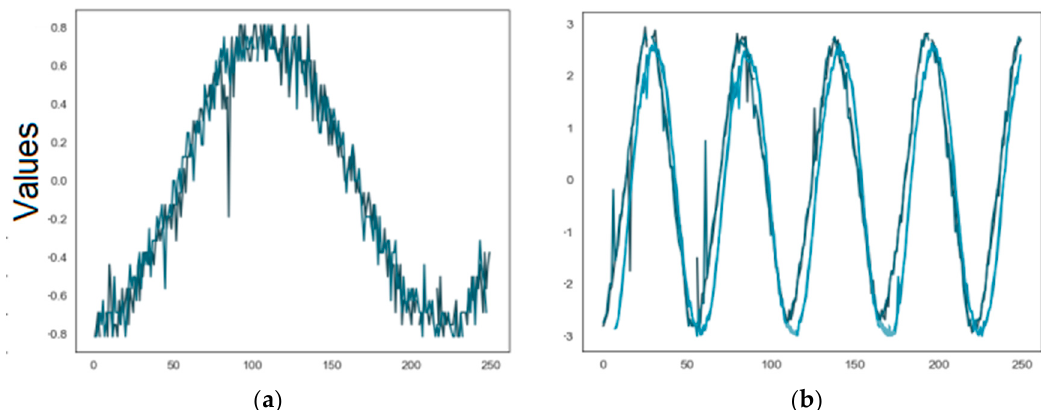
Figure 7. A set of current samples at low speed, low load, 100% magnetization ( a ) and full speed, full load 50% demagnetized ( b ). X-axis represents measurement’s time index while Y-axis represents its value.